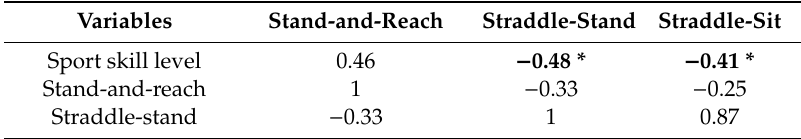
Figure2. Wardtreediagramfor7b–9aRPclimbers: (1)B-tro,(2)flexibilitytest(Grant),(3)author’sflexibility Figure 2. Ward tree diagram for 7b–9a RP climbers: (1) B-tro, (2) flexibility test (Grant), (3) author’s test (Draga test), (4) Draga-index (DI). flexibility test (Draga test), (4) Draga-index (DI). Table 3. Correlations of flexibility tests with sport skill levels for 7b–8c RP